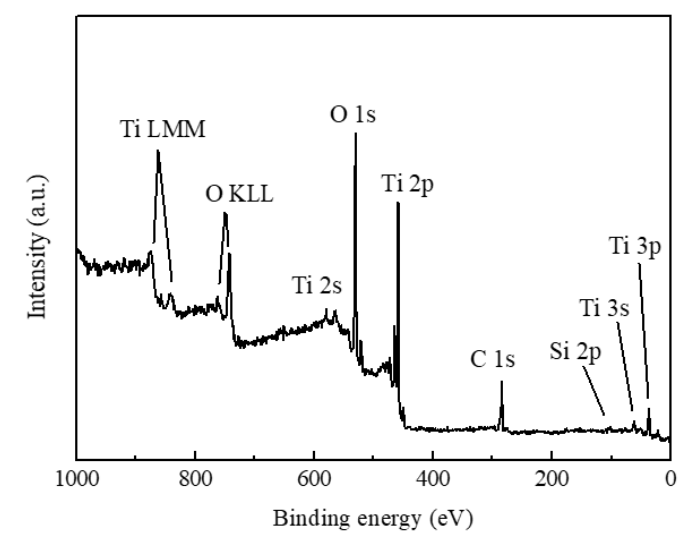
Figure 4. XPS survey spectrum of as-deposited TiO 2 films.